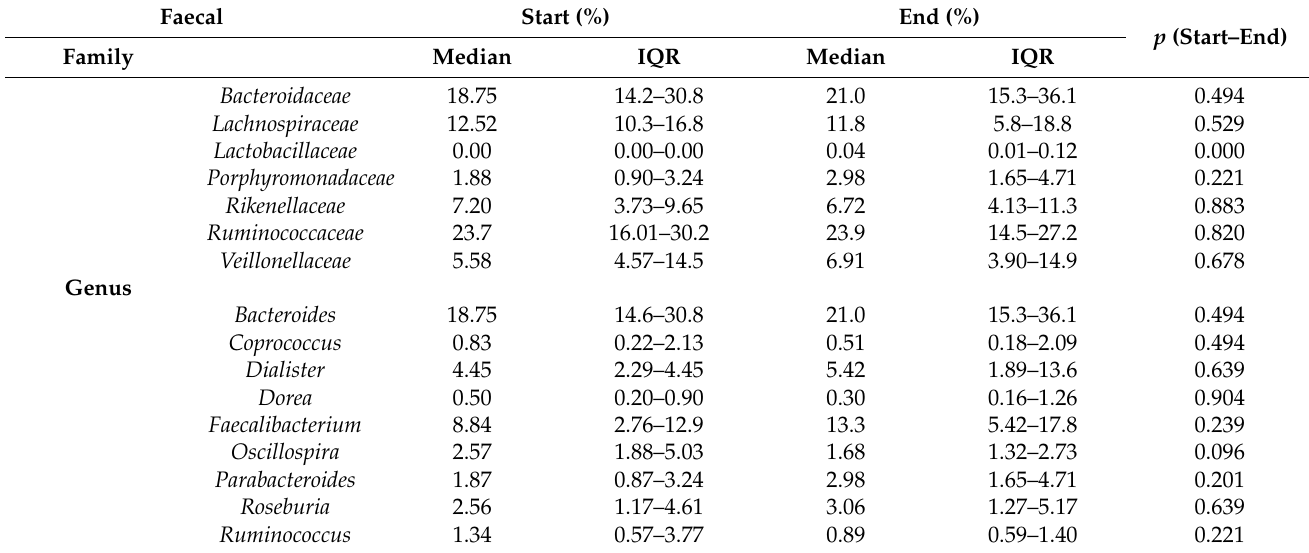
Table 6. Relative abundance of families and genera in faecal samples expressed as median and interquartile range (MD ± IQR) at the start and end of the study.